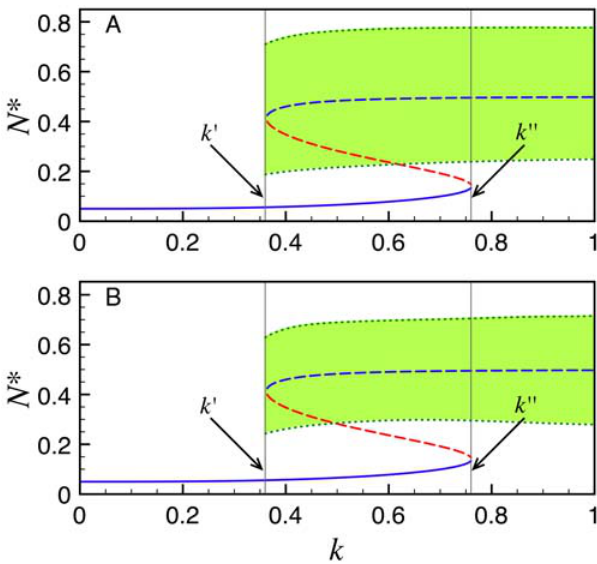
Figure 3. Bifurcation diagrams predicting the stationary behaviour of the models corresponding to the networks in Figures 1A (A) and 1B (B). The solid blue line denotes the N * values in a stable steady state, as a function of k ; the dashed red line represents a saddle node; the dashed blue line indicates an unstable steady state inside a limit cycle; and the green dotted lines correspond to the upper and lower limits of the N * oscillations in a stable limit cycle. All other parameters were set to the values estimated in the section on parameter estimation.